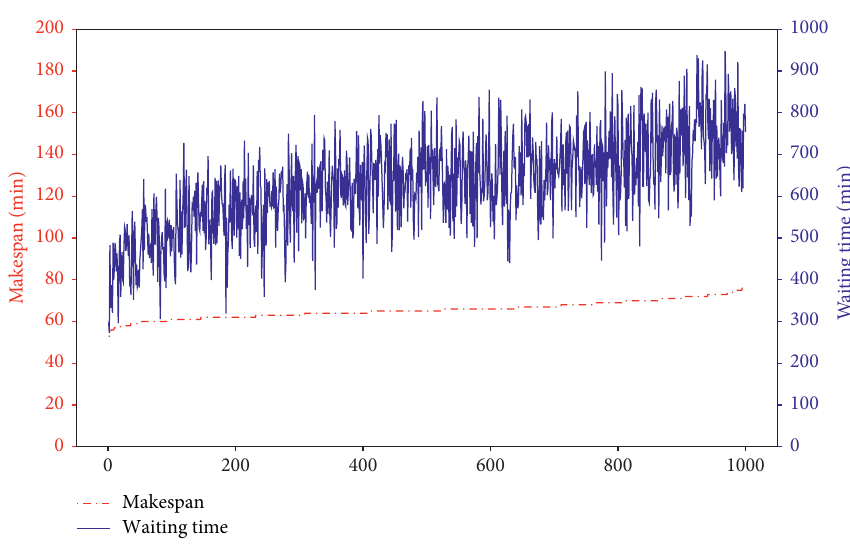
Figure 3: The experiment results of random generated